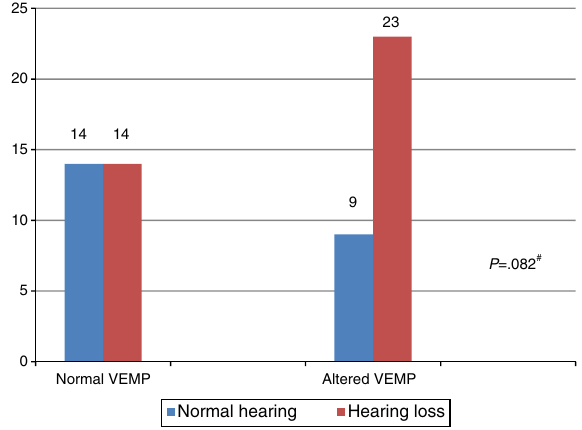
It is noteworthy that in the group with vestibular